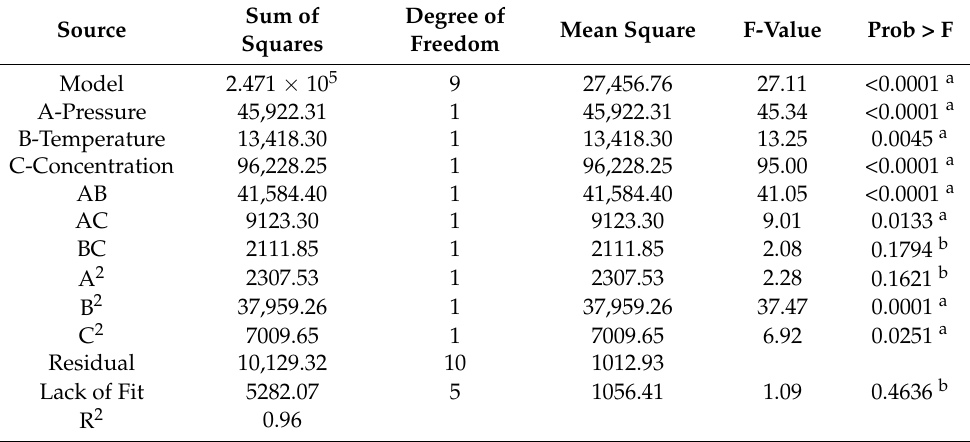
Table 3. Analysis of variance (ANOVA) for CO 2